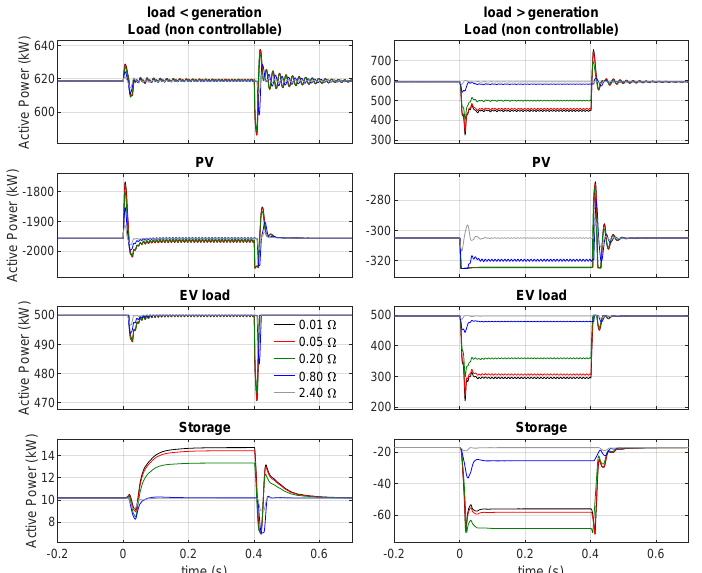
Figure 23. Active power per type of resources connected to the ST’s hybrid AC/DC network following unbalanced phase–phase faults in the HV AC grid for the considered fault resistances.